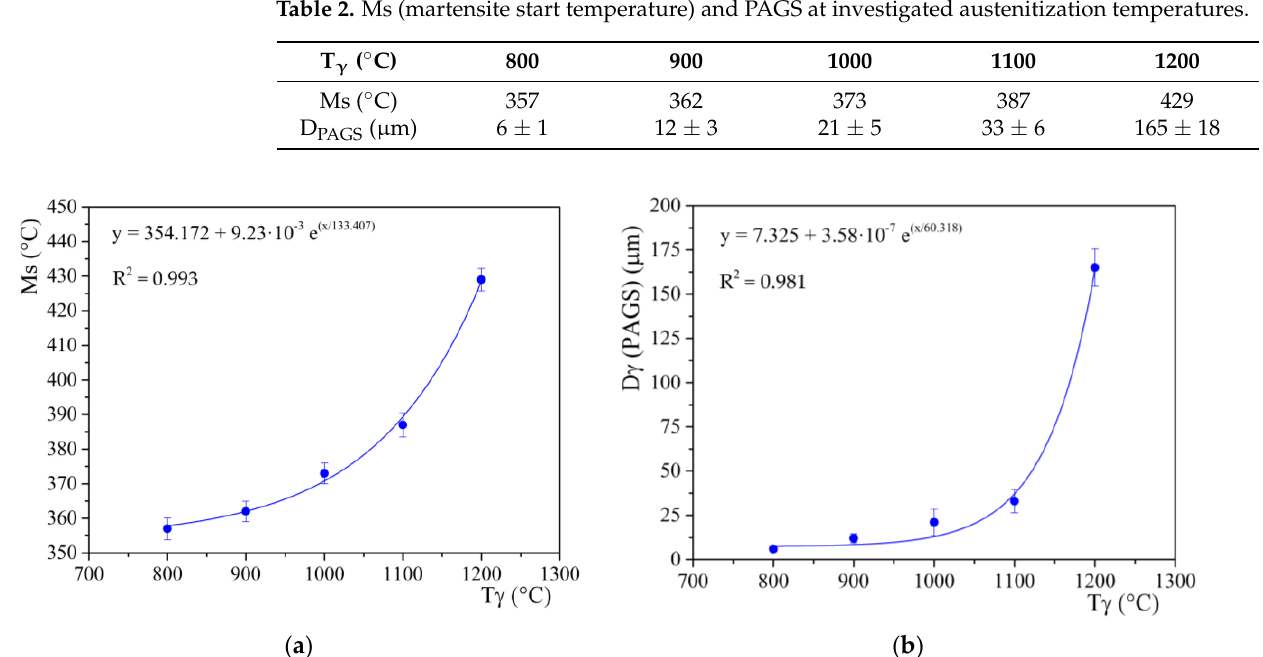
Figure 4. ( a ) Austenite grain boundaries determined by ImageJ at 1100 °C, ( b ) PAGS (prior austenite grain size) distribution calculation of its average value at austenitization temperature of 1100 °C. Table 2. Ms (martensite start temperature) and PAGS at investigated austenitization temperatures.